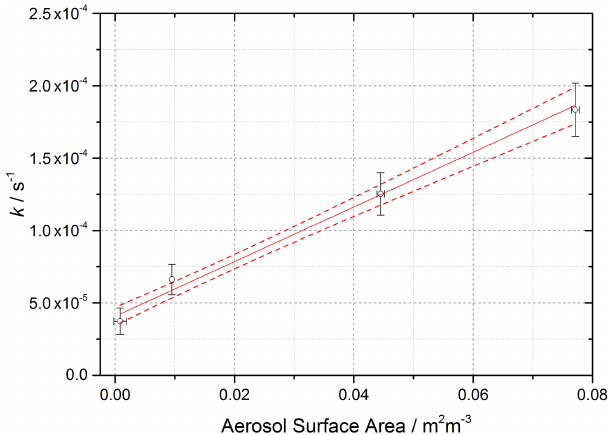
Figure 4. Pseudo-first-order rate coefficient for HONO produc- tion, k (open circles), as a function of aerosol surface area for [NO 2 ] = 200ppb and RH = 15 ± 1%, T = 293 ± 3K, and a photolysis time of 52 ± 2s. The red line is a linear-least- squares fit including 1 σ confidence bands (dashed lines) weighted to both x and y errors (1 σ ), the gradient of which yields = (2.17 ± 0.09) × 10 − 5 , with the uncertainty repre- γ NO 2 → HONO senting (1 σ ). The non-zero y -axis intercept is due to a back- ground HONO signal owing to the presence of a HONO im- purity in the NO 2 cylinder, which is not subtracted. The total photon flux of the lamp (see Fig. 2 for its spectral output) = (1.63 ± 0.09) × 10 16 photonscm − 2 s − 1